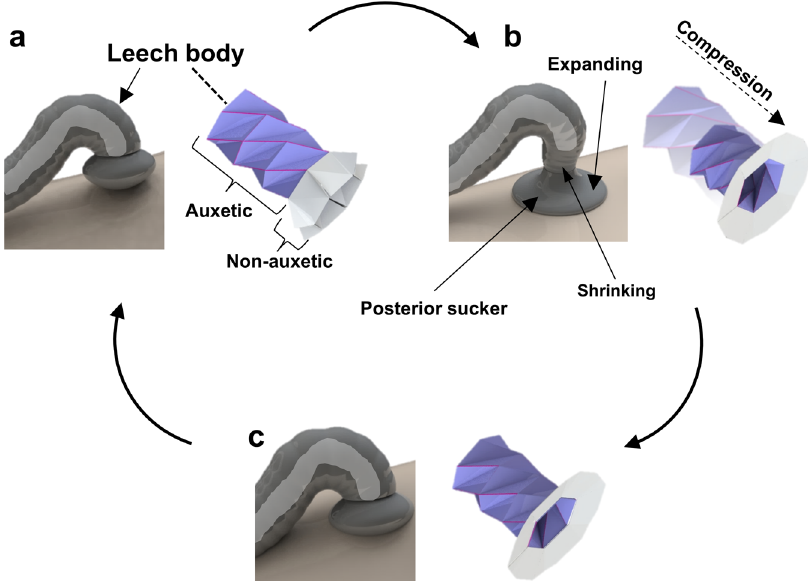
Fig. 1 Design of Leech-inspired origami (LIO). Schematics of the sticking mechanism of the posterior leech sucker. a Before the attachment, the shrunk sucker is positioned to target the skin surface. b The sucker part of the leech is stretched out along the radial direction and shrunken the body to attach to the skin. c The leech ’ s body expands for the pumping to the victim ’ s blood. The body trunk of the leech was mimicked by auxetic design, and the sucker was mimicked by non-auxetic origami design. The 3D origami composed of non-auxetic tip and the auxetic trunk is proposed in this